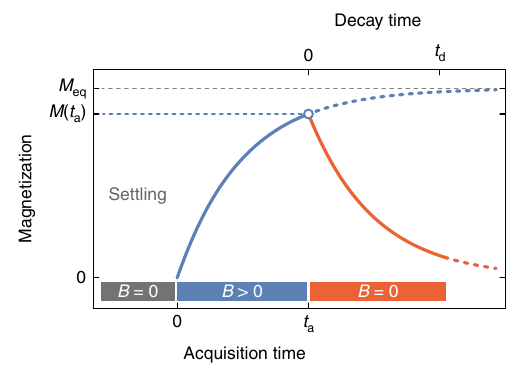
Figure 2 | Timing of PDRM acquisition experiments. Sediment is initially settled in a zero field ( B ¼ 0) for B 5 days. PDRM acquisitions occurs after a controlled field ( B 4 0) is applied for t a D 7 days. During this time, the equilibrium magnetization, M eq , is approached. Finally, the acquired magnetization, M ( t a ), is allowed to decay in a zero field for a time t d . The remanent magnetization during acquisition and decay phases is measured at regular time